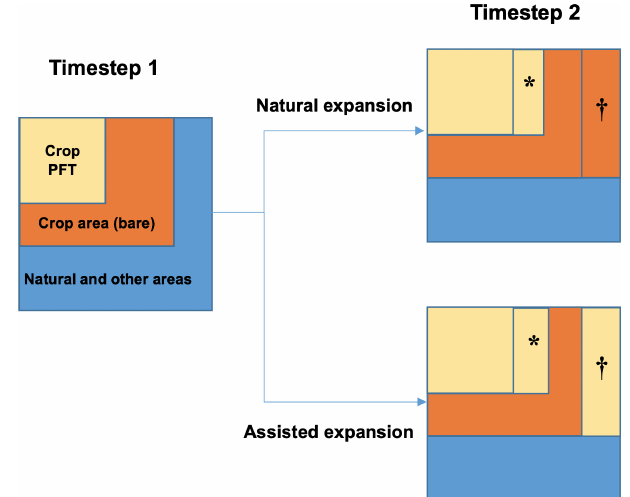
Figure 1. Schematic of the agricultural expansion functionality in JULES-BE. A full description of the process is provided in Sect. 2.3. The area marked with ∗ represents the change in the plant functional type (PFT) area that would occur without the change in crop area ( (cid:49) frac na in Eq. 6). The area marked with † represents the newly available agricultural area ( (cid:49) frac ag in Eq. 6), which is im- mediately populated with the crop PFT where assisted expansion is enabled, or left bare where it is